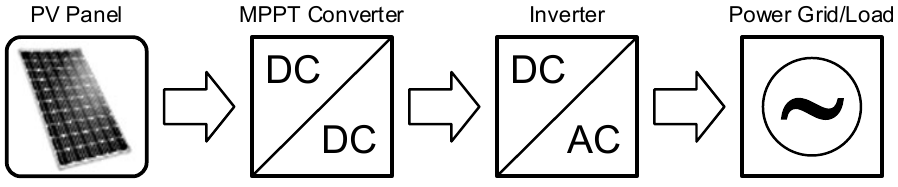
Figure 8. DC–DC boost converter together with a three-phase rectifier bridge, connected to a PV installation, implemented in Matlab/Simulink.